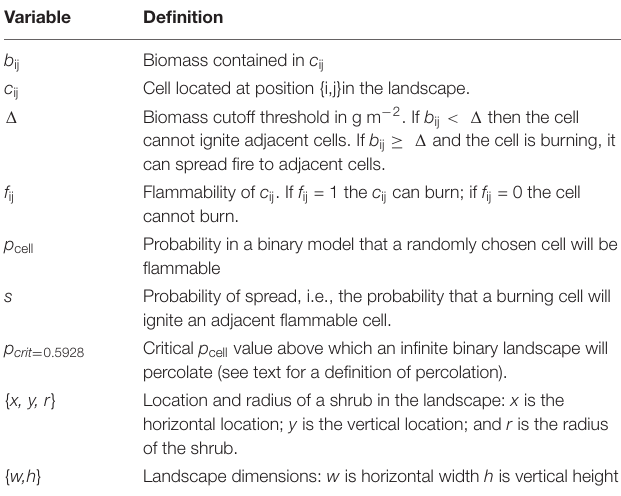
TABLE 1 | Definitions of variables used in the model and analyses.